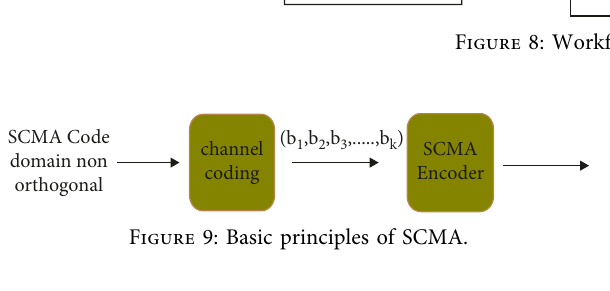
Figure 8: Workflow of BootLoader.